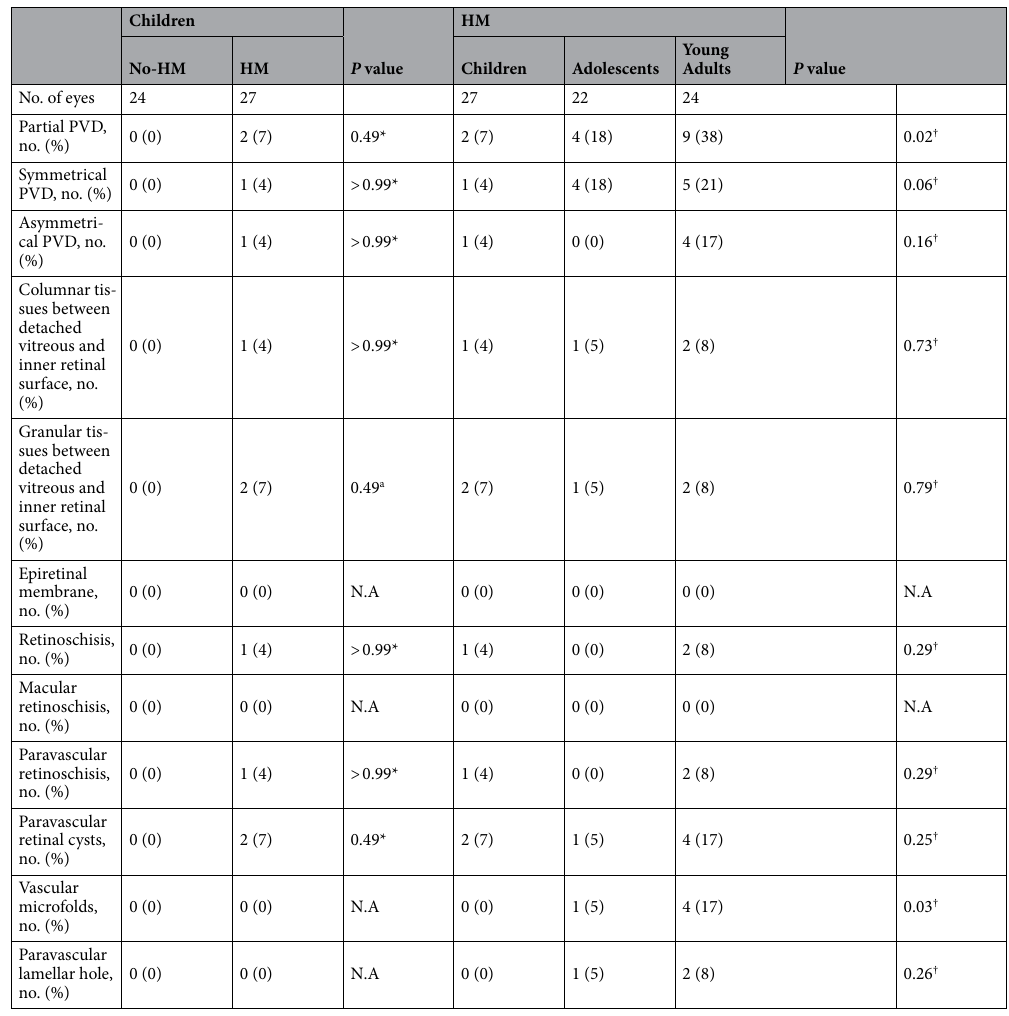
Table 2. Comparisons of UWF-OCT findings between highly myopic and non-highly myopic children, and between different age groups of highly myopic patients. HM high myopia, PVD posterior vitreous detachment, N.A not applicable. *Fisher’s exact probability test. † Chi square